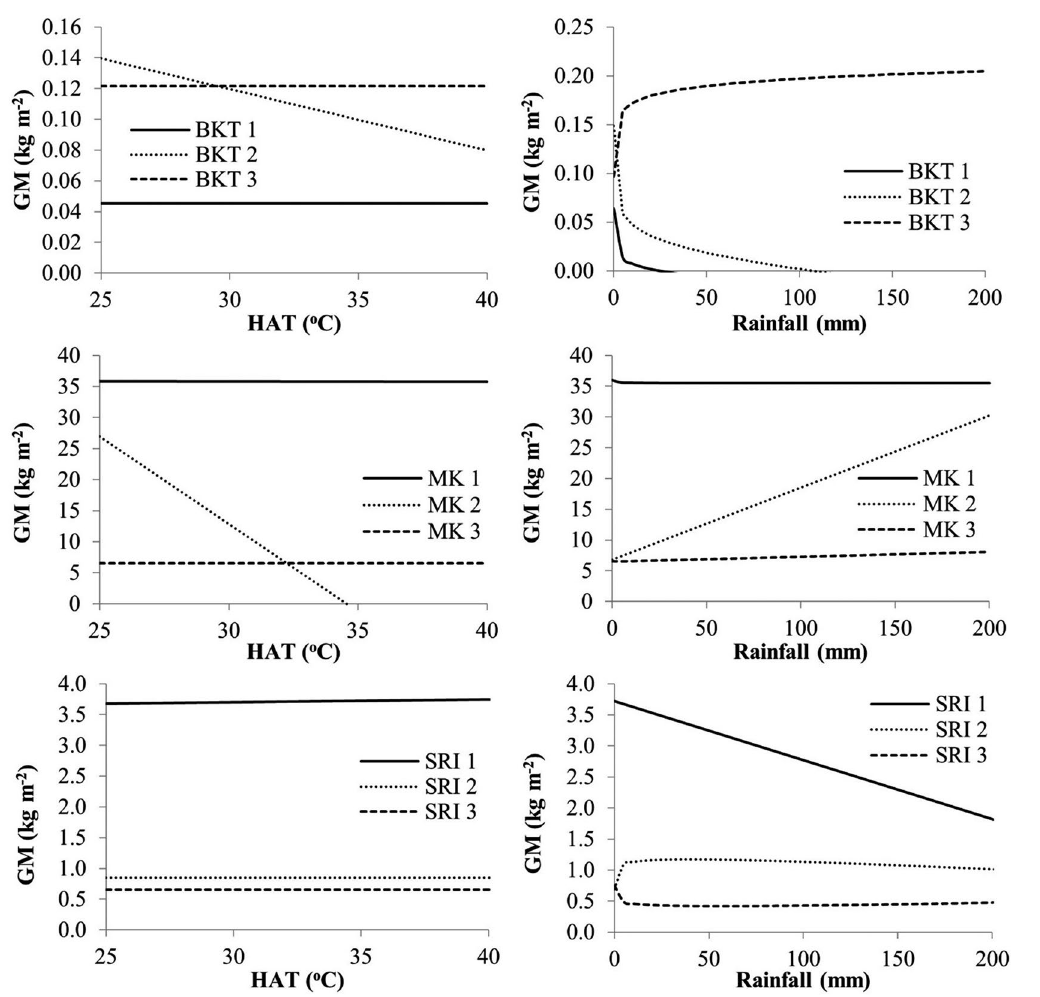
Fig. 7. – Simulations of green mussel production (GM) based on variations of the average of the highest air temperature (HAT) and rainfall in the pond area of Bang Khun Tien (BKT), the estuary area of the Maeklong river mouth (MK) and the coastal area of Sriracha